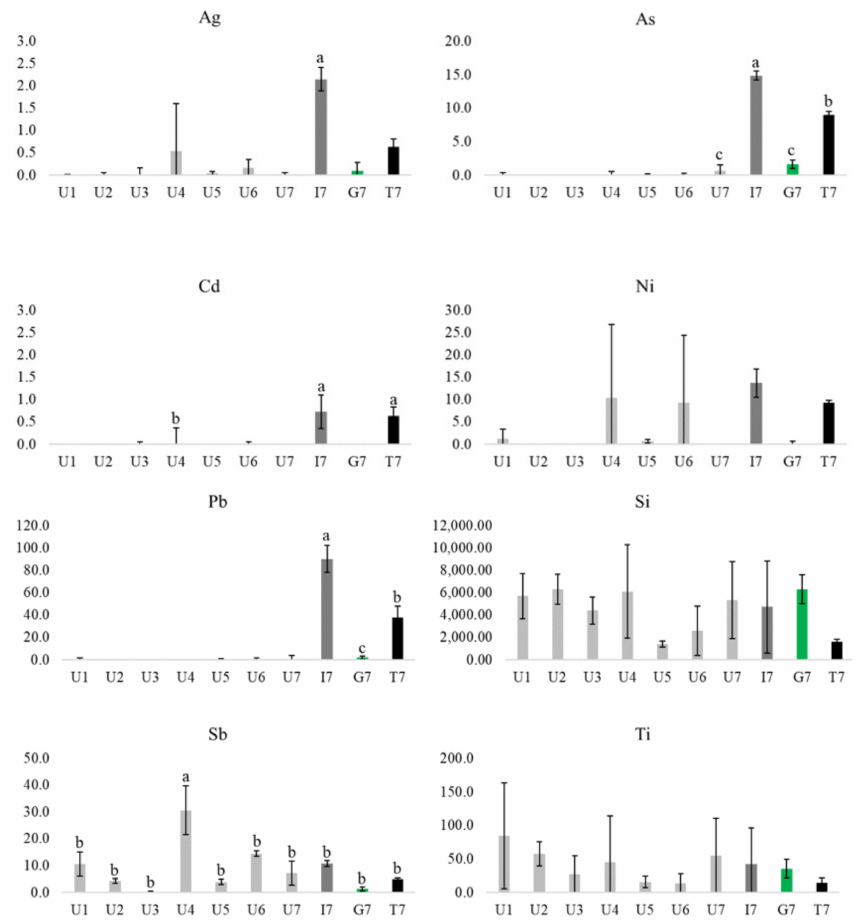
Figure 3. Daily deposition flux ( µ g m − 2 d − 1 ) for several accumulated elements measured at each route. Different letters indicate significant differences between routes ( p <